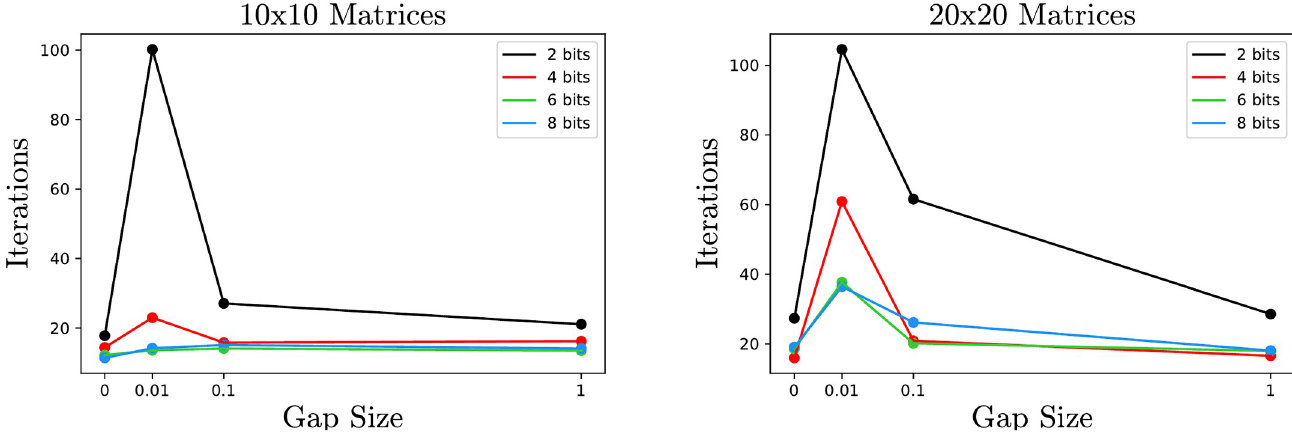
Fig 7. Average number of iterations on 30 samples as a function of the gap size | λ 1 − λ 2 |. The smaller the gap, the more iterations required, especially when the number of bits is small. In the extreme case where the gap is 0 and the lowest eigenvalue appears with multiplicity, the algorithm is actually faster in the sense that fewer iterations are needed for the computed eigenvalue to approximate the true